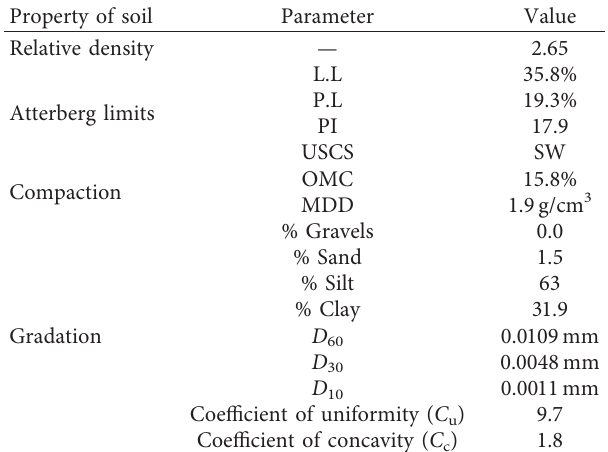
Table 5: Properties of soil